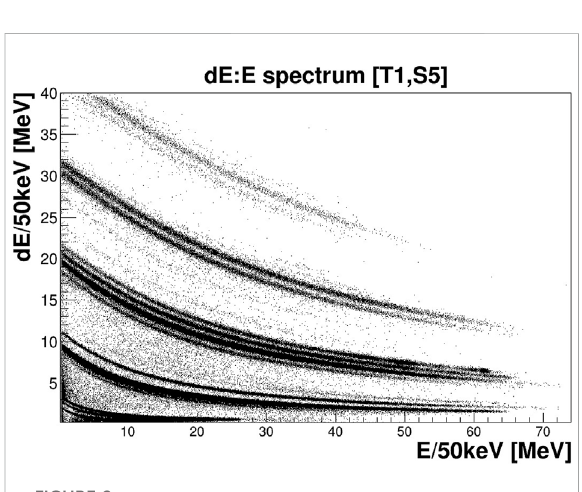
FIGURE 2 Typical particle identi fi cation of Δ E – E spectrum obtained for one strip in the E detector: here, the spectrum for strip 5 of telescope T1 is shown. Observed loci correspond to the (from bottom to top) 1,2,3 H, 3,4,6,8 He, 6,7,8,9 Li, 7,9,10,11,12 Be, and 10,11,12